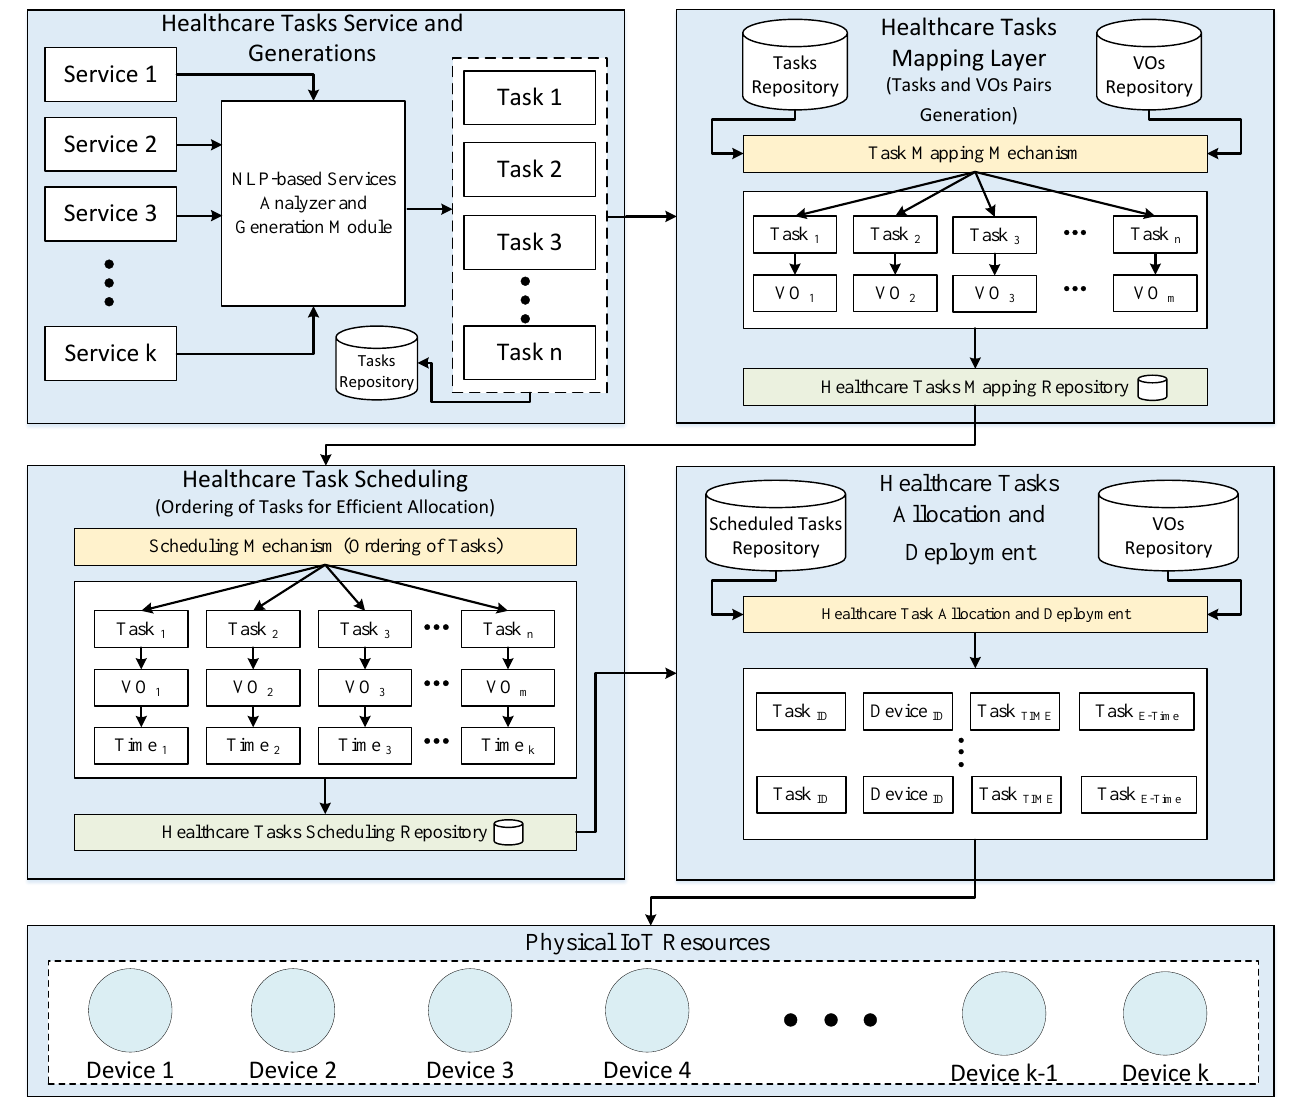
Figure 2. Task Orchestration Architecture for Efficient Tasks Allocation in Smart